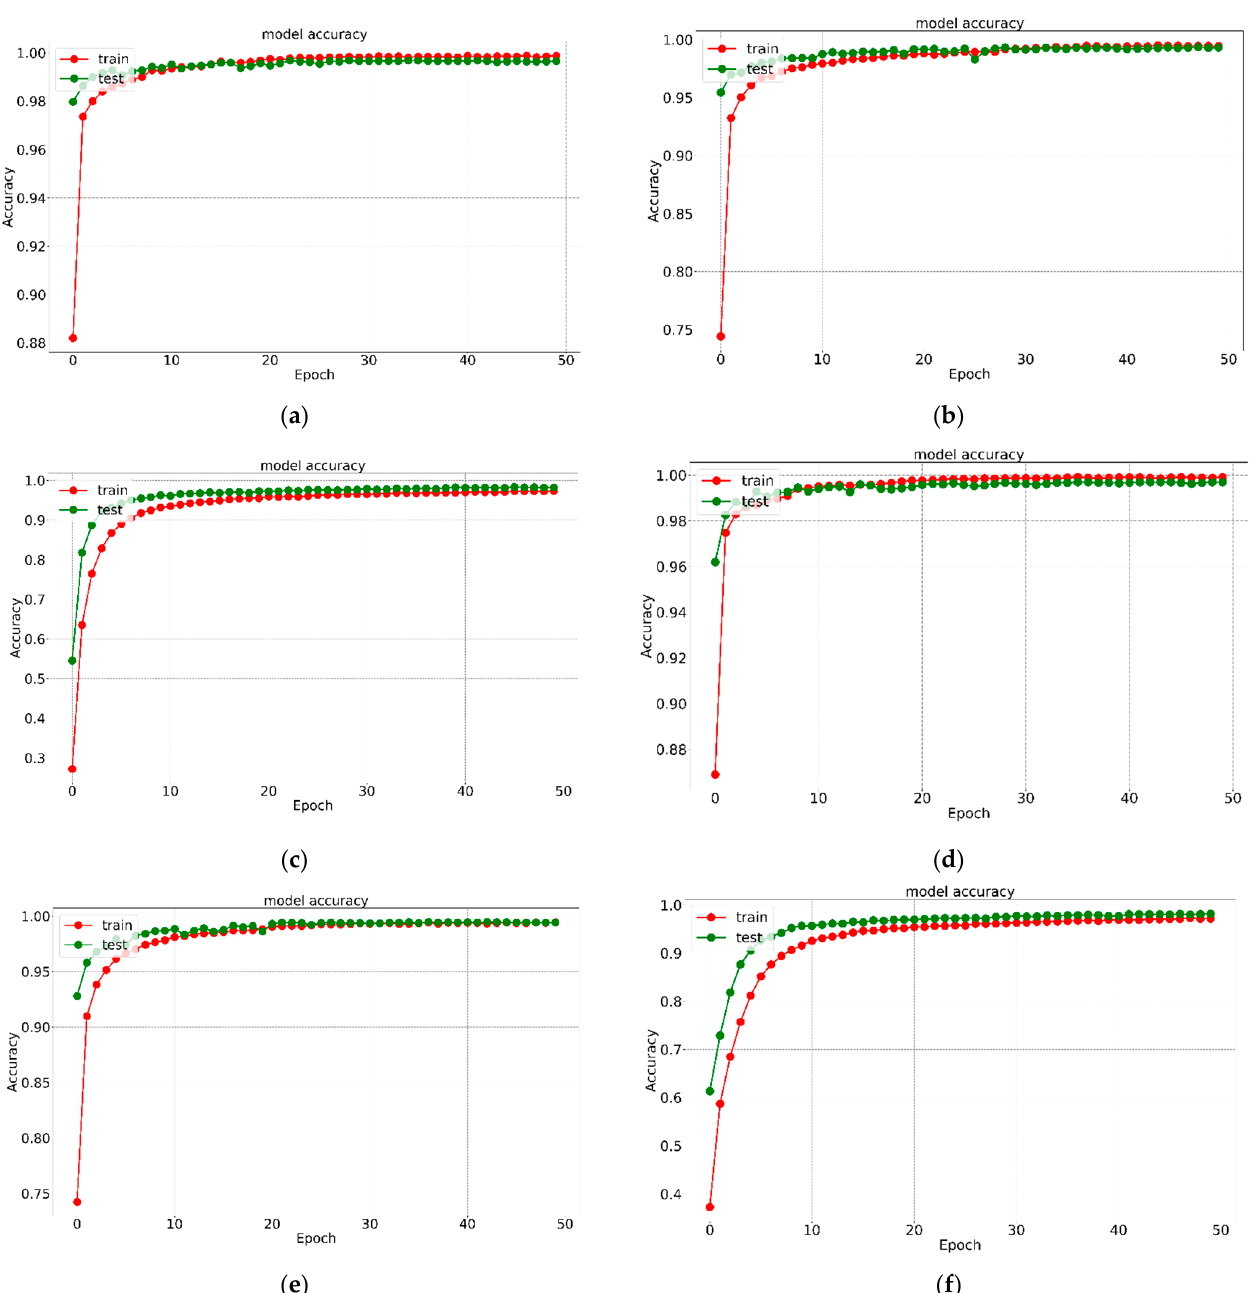
Figure 9. Validation accuracy of the six models for digit (0–9) recognition. ( a ) Optimizer—‘ADAM’; learning rate—0.001. ( b ) Optimizer—‘ADAM’; learning rate—0.0001. ( c ) Optimizer—‘ADAM’; learning rate—0.00001. ( d ) Optimizer—‘RMSprop’; learning rate—0.001. ( e ) Optimizer—‘RMSprop’; learning rate—0.0001. ( f ) Optimizer—‘RMSprop’; learning rate—0.00001.